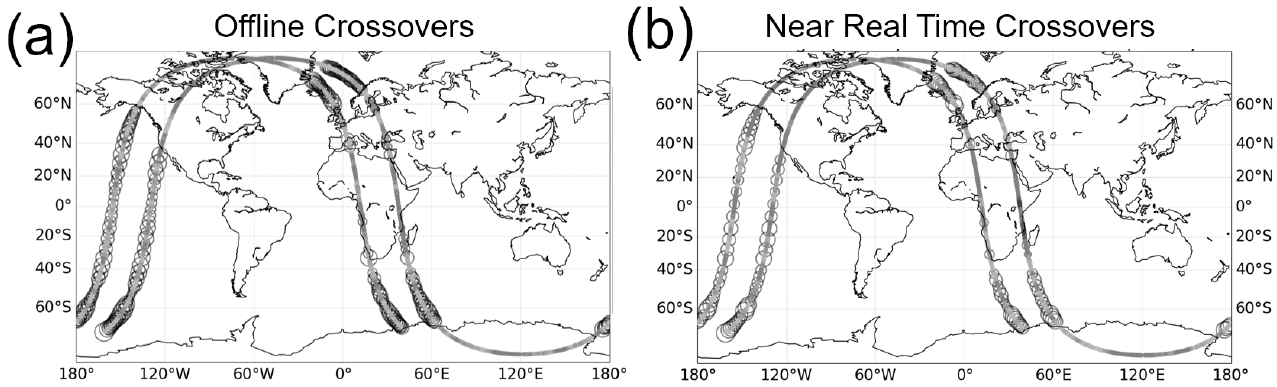
Figure 19. Location of ocean crossovers (black circles) for two arbitrary passes. Panel ( a ) is for delayed time, i.e., offline reprocessing. Panel ( b ) is for near-real time. To summarize, in near real time, the RMSE after calibration increases by less than 5% for the Level-3 algorithm (because of the low quality of the NRT nadir-altimeter prior), and less than 15% for the 21-day orbit Level-2 algorithm (i.e., largely covered by our mar- gins to meet the hydrology requirements). Based on the margins reported in Section 4, there is no performance issue to operate the calibration algorithm in near real time.